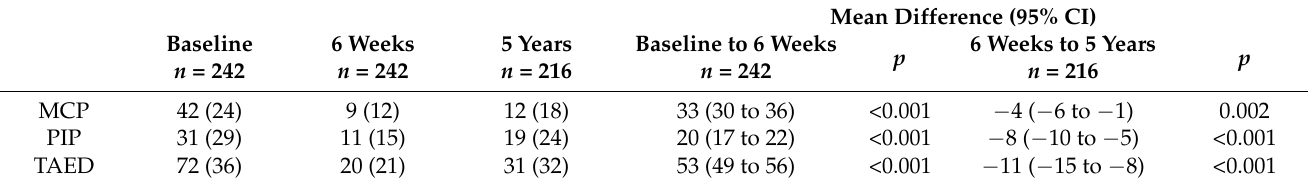
Table 2. Active extension deficit in